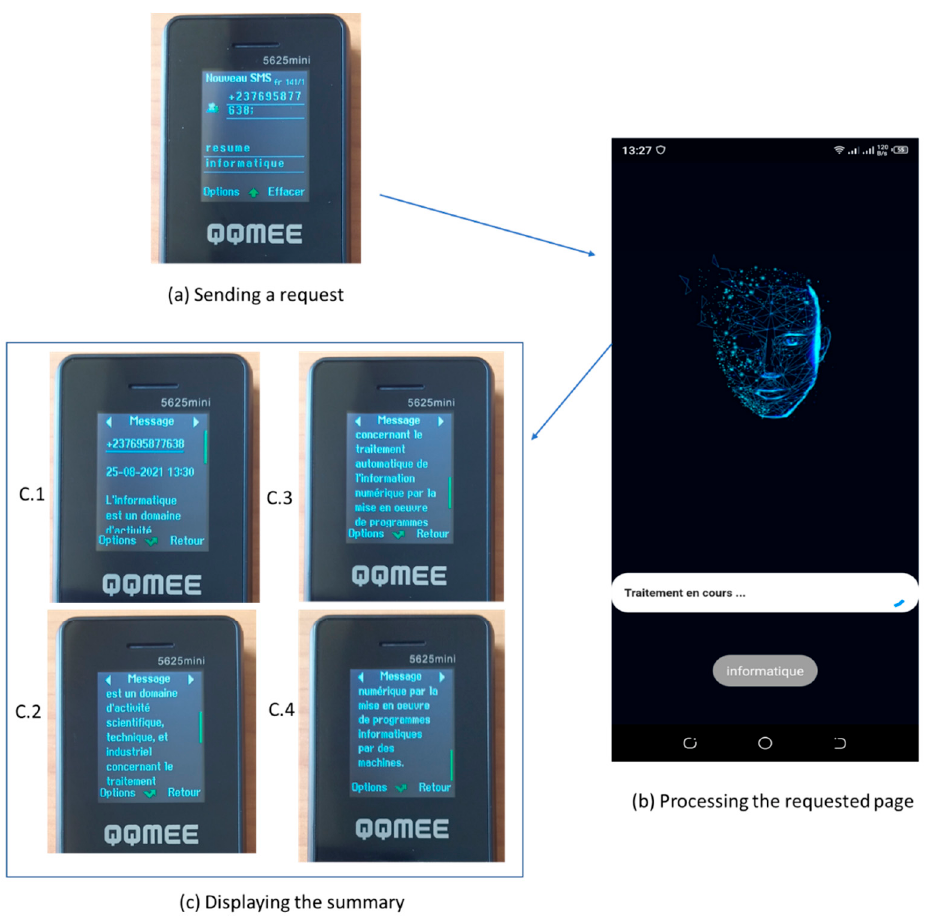
Figure 4. Demo of using WATS-SMS. ( a ) A request is sent with the word “Informatique”. ( b ) The requested page is processed by the SMS Gateway that communicates with the Summarizer. ( c ) The summary is provided to the